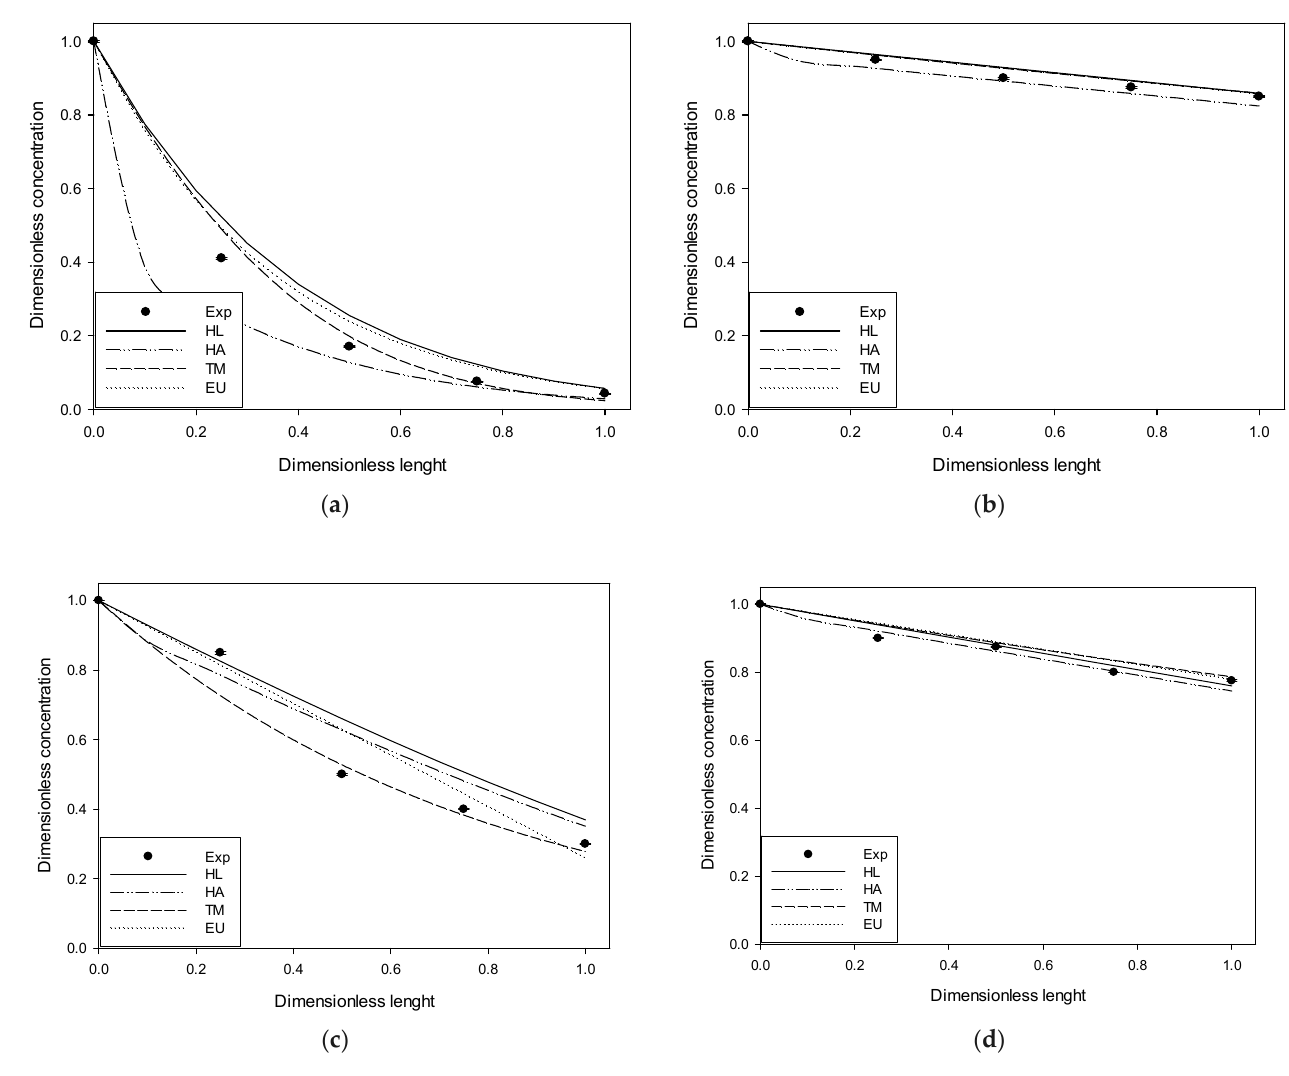
Figure 4. Nondimensional simulation results compared to experimental data with 20 ppm of input. ( a ) H 2 S, ( b ) DMS, ( c ) MM, ( d ) DMDS. Table 4. Determination coefficients R 2